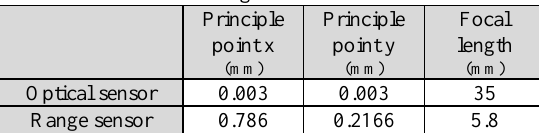
Table 3. Interior orientation parameters of optical and